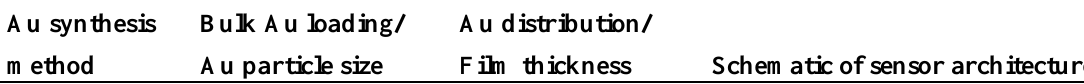
sensor architectures considered. All SnO materials were 2 2 particle size of 15 nm based on 2